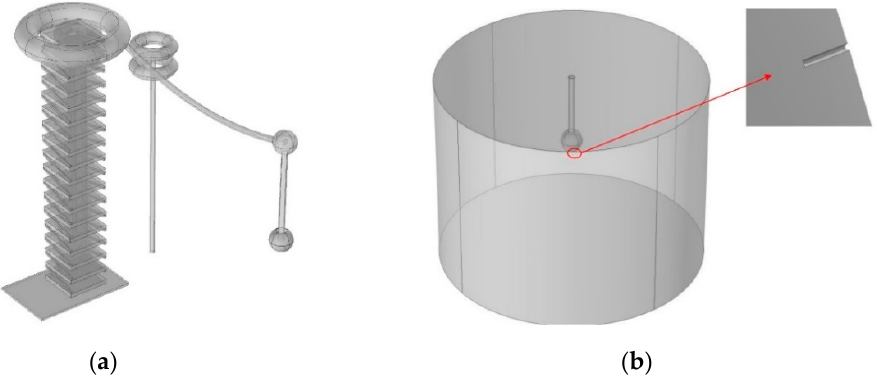
Figure 5. Simulation model of the test: ( a ) the model of the test hall; ( b ) the sub-model method.